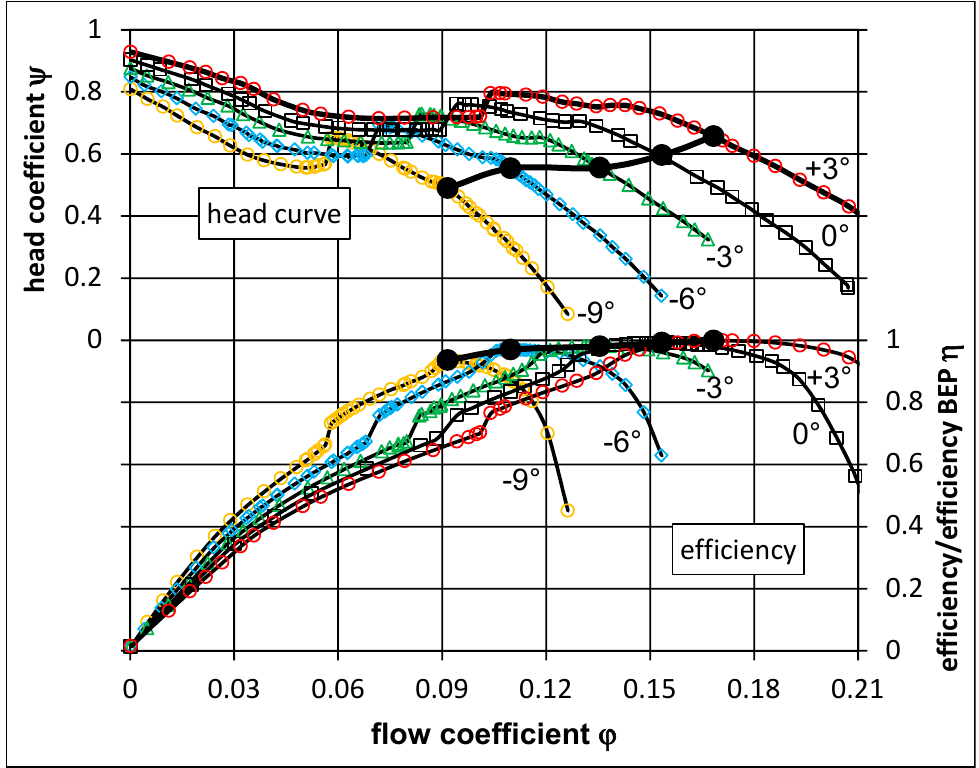
Figure 2. Head curves and relative efficiencies for a variable pitch pump.